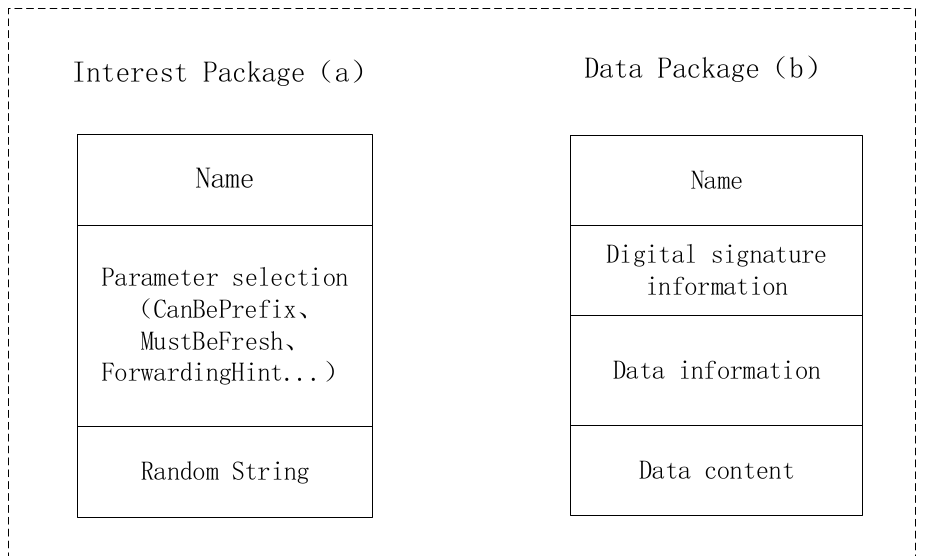
Figure 1. The interest packet ( a ) and the data packet ( b ).